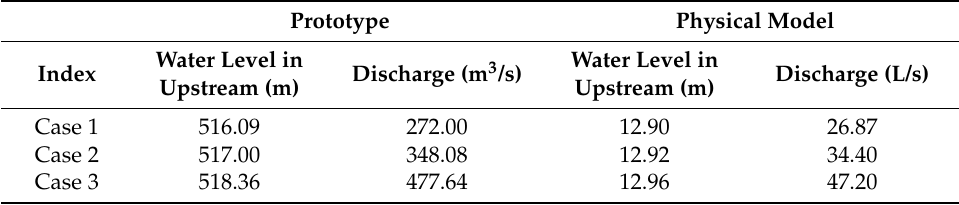
Figure 3. The experimental arrangement of the reservoir. Table 1. The conditions of the prototype and physical experimental